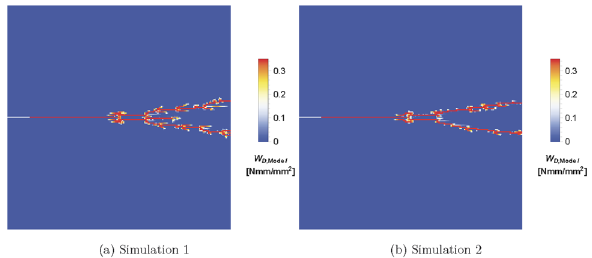
Fig. 34 Single edge notched specimen. Dissipated Mode I fracture energy for a perturbed